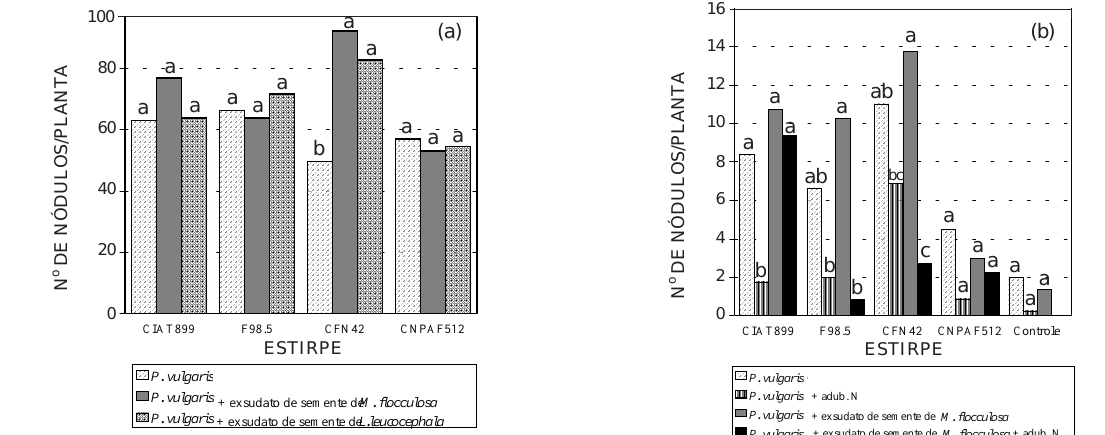
NodD pode atuar como um complexo multimérico, interagindo com diferentes flavonóides indutores (Dénarié et al., 1992). Neste caso, a proteína NodD apresentaria vários sítios de ligação com indutores, ocasionando uma atividade mais elevada. Outra possível explicação estaria relacionada com o efeito